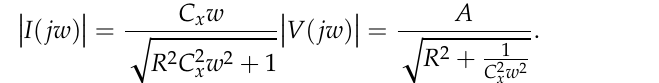
Figure 10. The relationship between current and frequency as the input is sinusoidal wave.